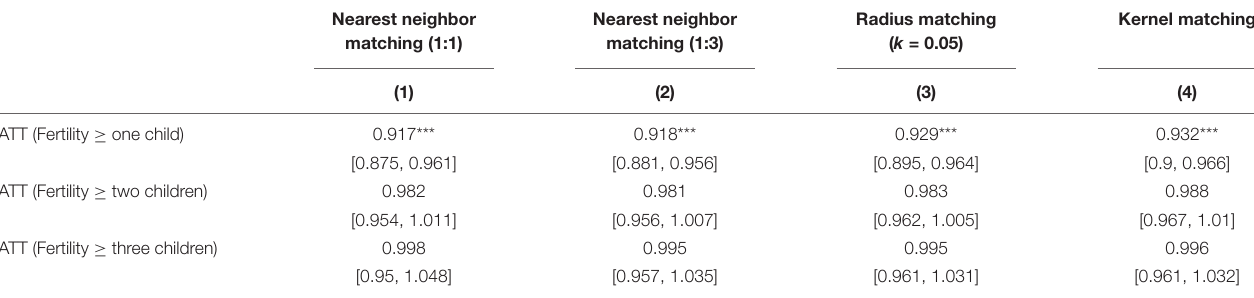
TABLE 6 | Estimates of propensity score matching on the association between fertility behavior and depressive symptoms among women.